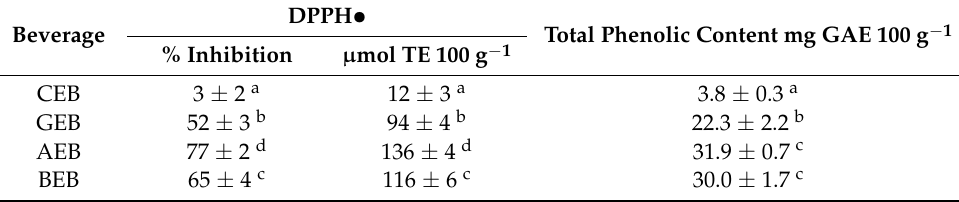
Table 2. Antioxidant activity and total phenolic content of the beverages after 28 days of storage.